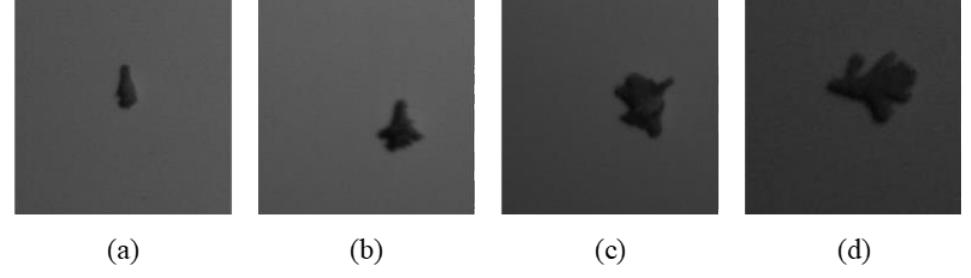
Figure 3. Images of cropped larvae, ( a ) S2, ( b ) S3, ( c ) S4, ( d ) S5.